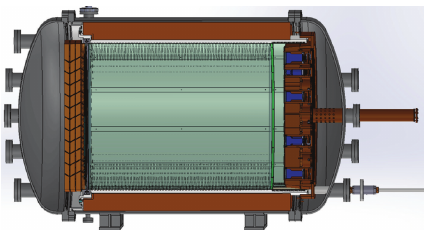
Figure 8: A 3D drawing of the NEXT-100 detector, showing the pressure vessel (gray), the internal copper shield (brown), and the field cage (green). The PMTs of the energy plane are shown in